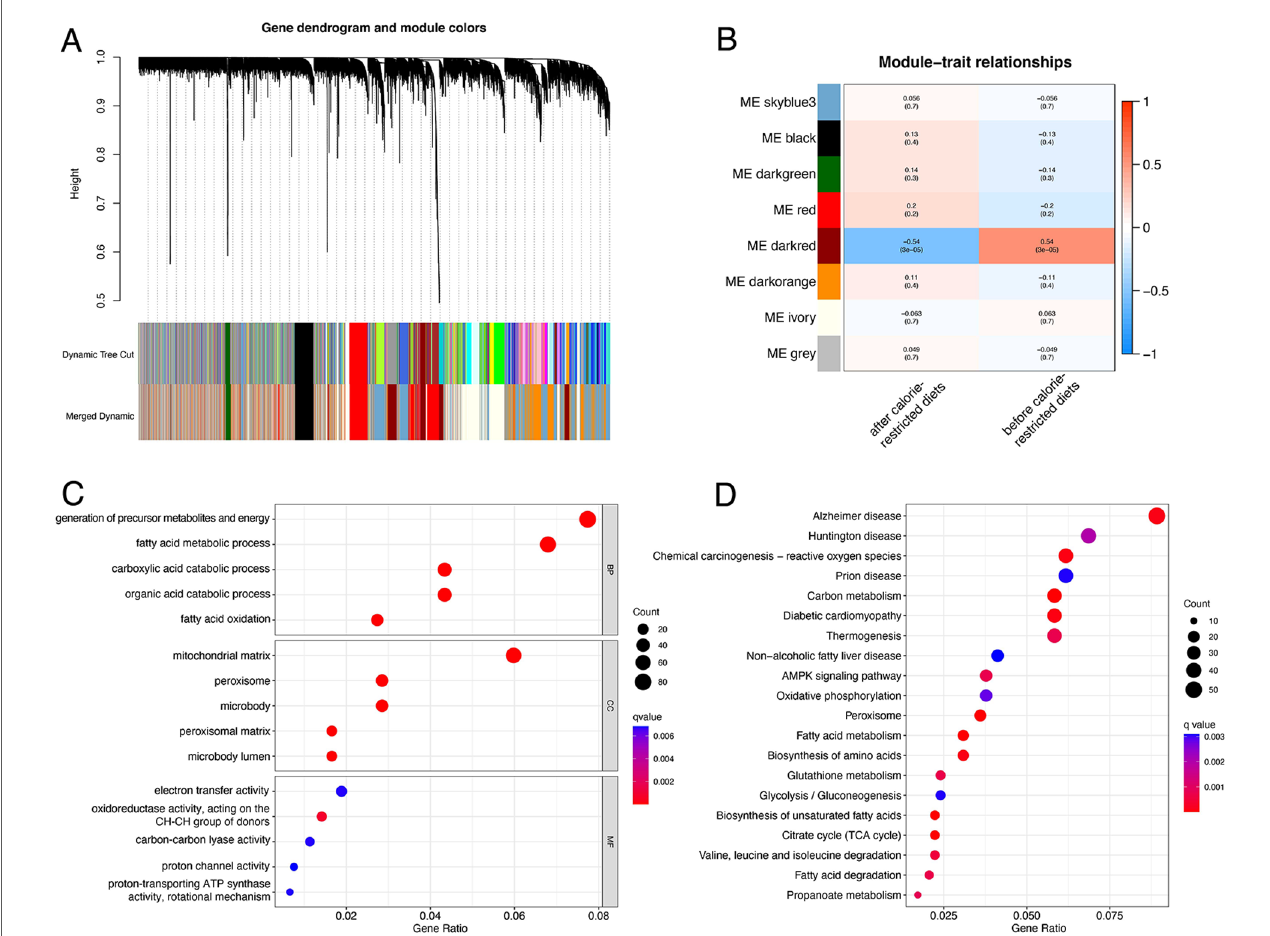
FIGURE 2 Identi fi cation and functional annotation of ORGs. ( A ) The cluster dendrogram of ORGs in obesity. ( B ) Correlation of WGCNA modules and obesity. ( C ) GO analysis of ORGs. ( D ) KEGG analysis of ORGs. ORGs, obesity-related genes. WGCNA, weighted gene co-expression network analysis. GO, Gene Ontology. KEGG, Kyoto Encyclopedia of Genes and